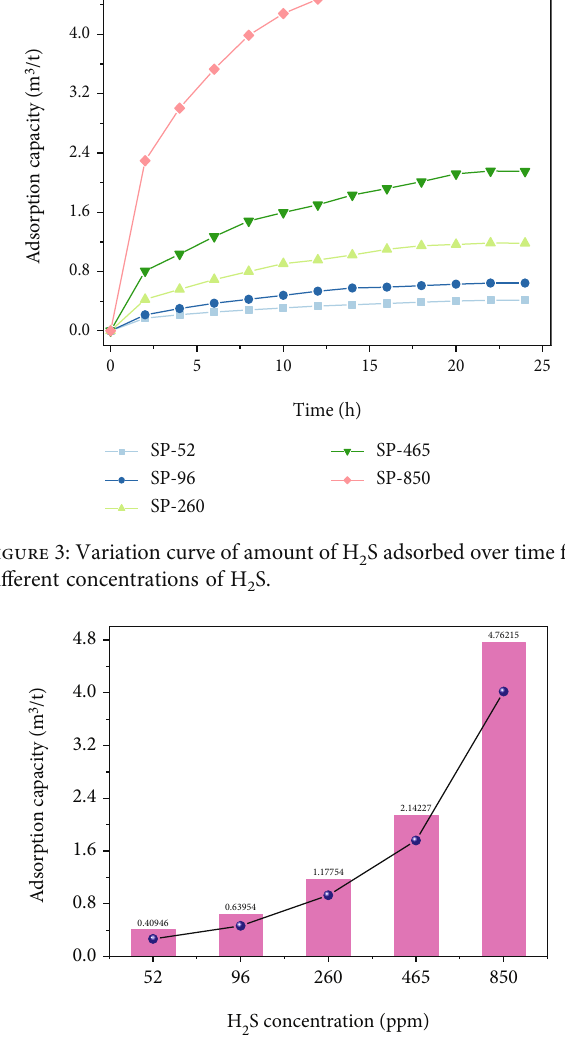
S concentration and saturation 2